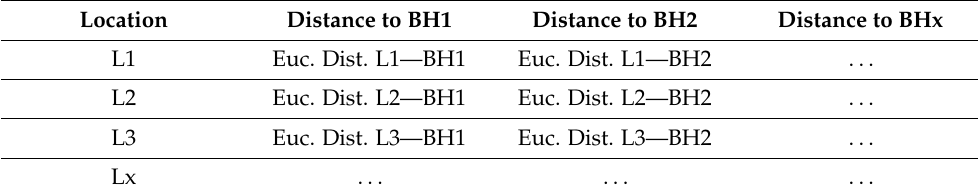
Figure 4. Illustration of Euclidean distance Field. Table 2. Illustration of the Euclidean distance data transformation.